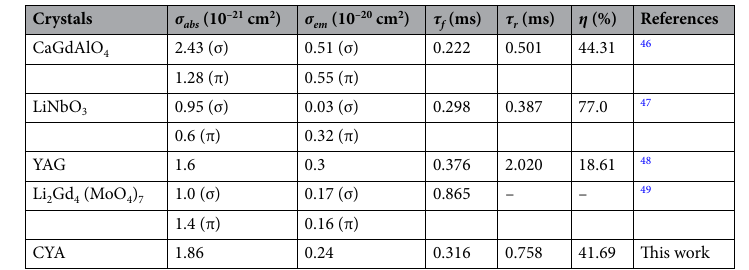
Table 5. The main optical parameters of some Dy 3+ -doped crystals.